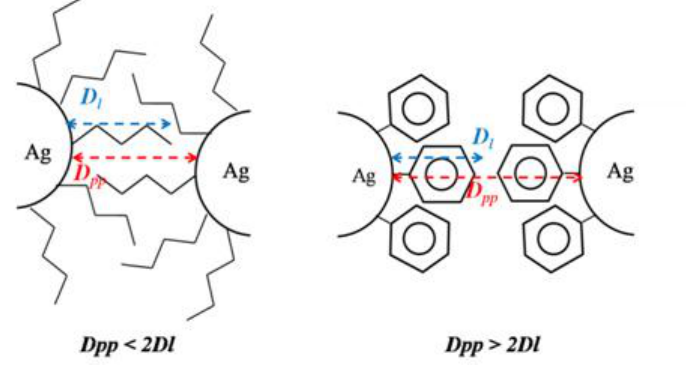
Figure 1. Schematic representation of different interaction of thiol-capped silver